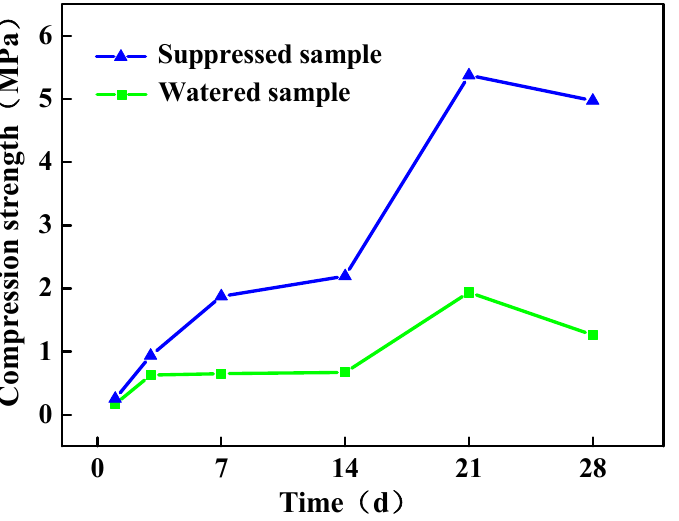
Figure 5. The changes in the compression strength of the soil for backfilling with time at room temperature.